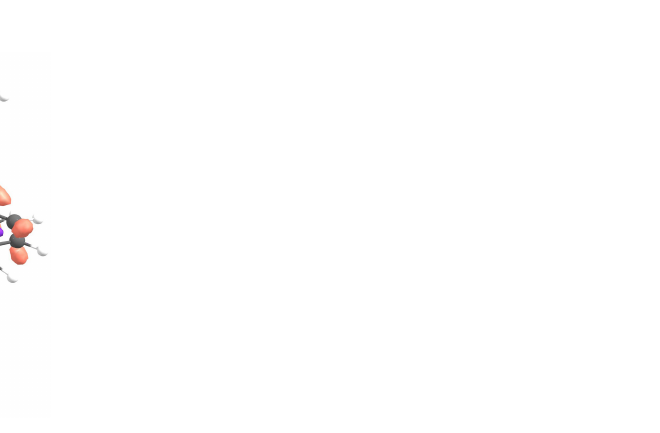
Figure 6. The TD-B3LYP/6-31G(d) density difference of the S 1 state at its minimum geometry in the D1 dimer of TPF obtained from QM(TD-B3LYP)/QM’(DFTB) optimisations.